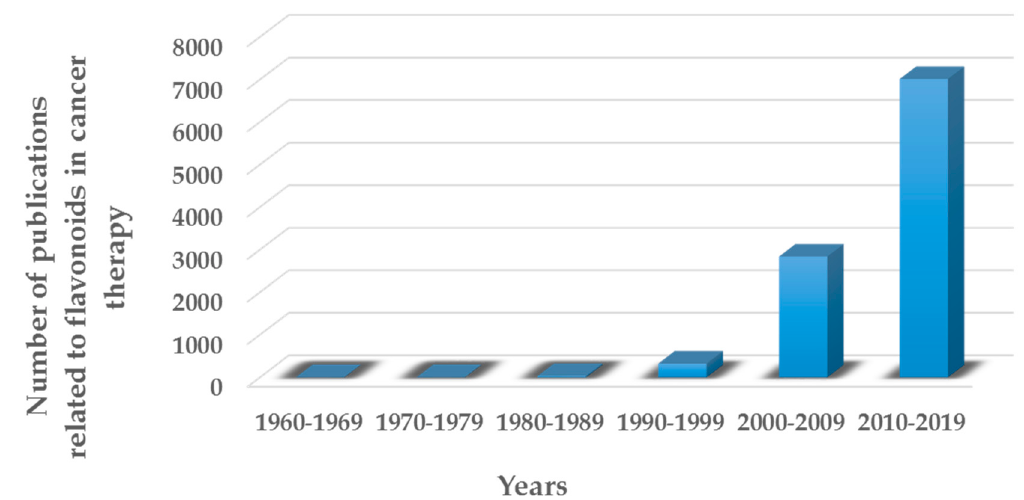
Figure 5. Number of peer-reviewed articles published in the last decades in the field of flavonoids in cancer therapy.